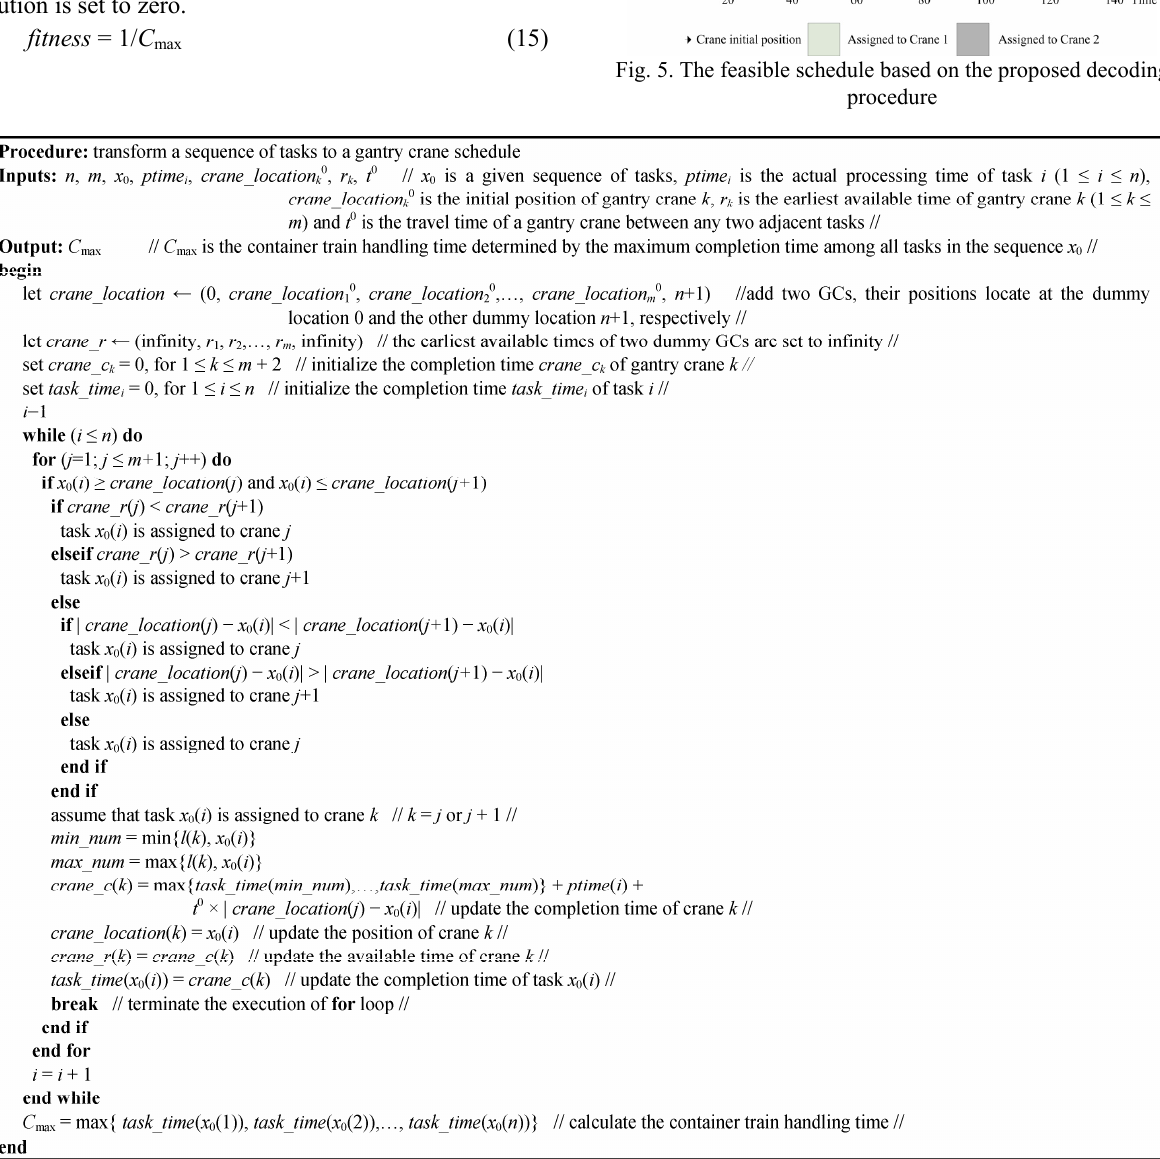
Fig. 4. The proposed decoding